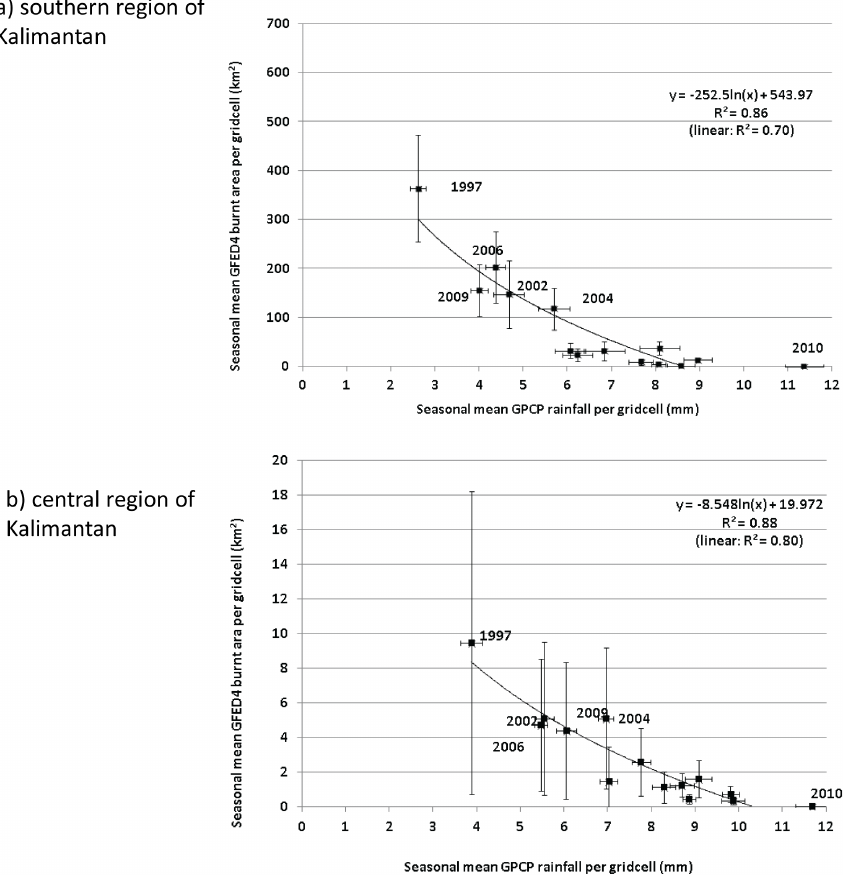
Figure 2. (a) Southern region of Kalimantan: seasonal mean GFED4 burnt area per grid cell as a function of seasonal mean GPCP rainfall per grid cell; and (b) central region of Kalimantan: seasonal mean monthly GFED4 burnt area per grid cell as a function of seasonal mean GPCP rainfall per grid cell. The edges of the whiskers refer to the 5th and 95th percentiles ( ± 1.96 × SE mean ).